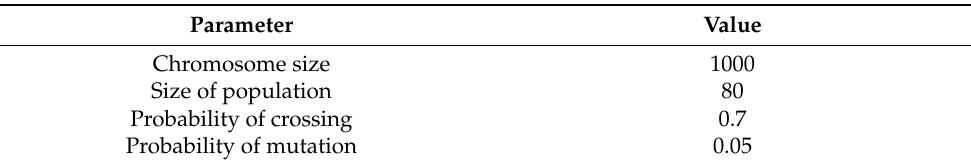
Probability of mutation 0.05